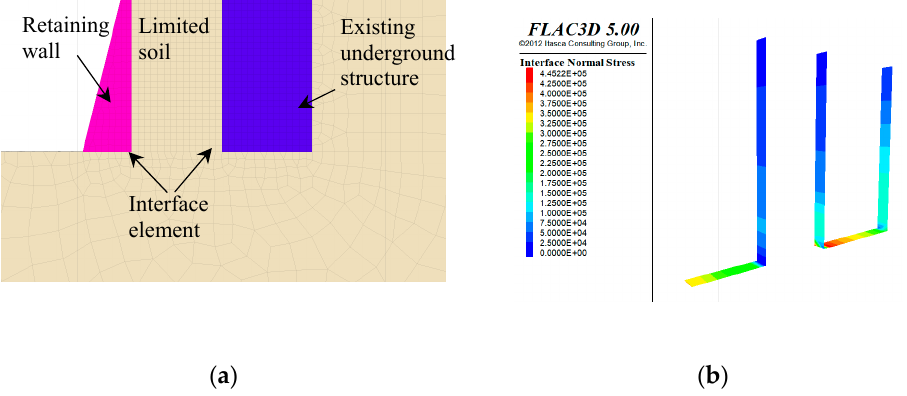
Figure 8. Numerical calculation model of ( a ) model mesh and ( b ) interface element.